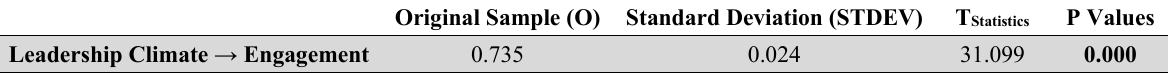
Original Sample (O)